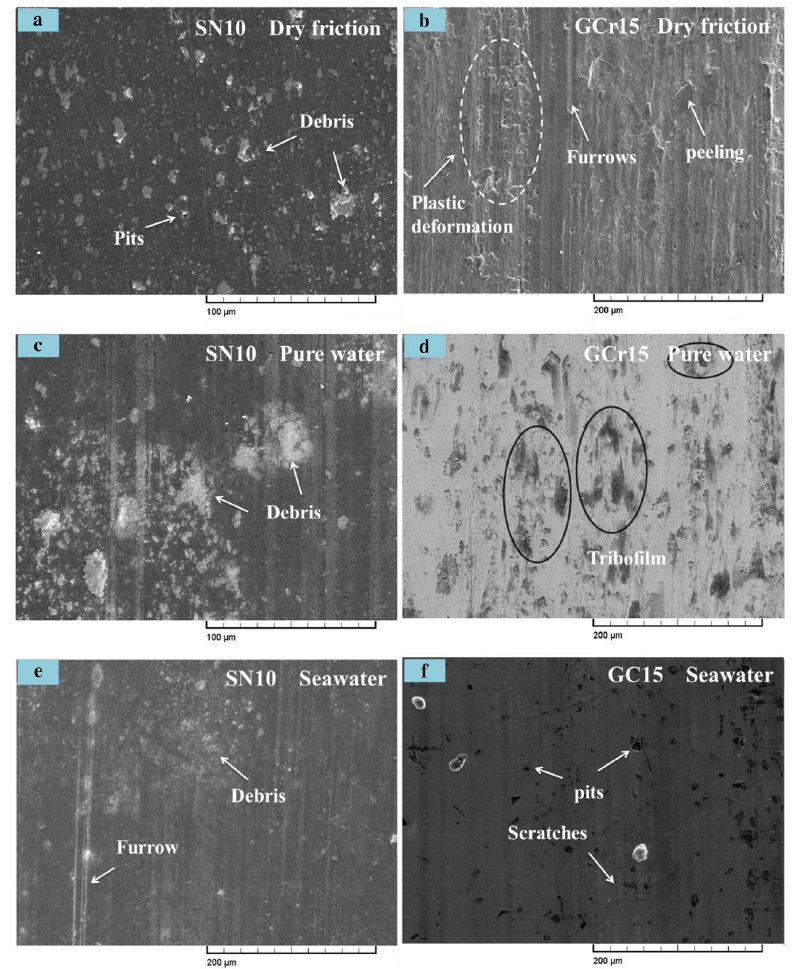
Figure 5. Scanning Electron Microscopy (SEM) images of the worn surfaces of SN10 ( a , c , e ) and GCr15 ( b , d , f ) under dry friction ( a , b ), pure-water lubrication ( c , d ), and seawater lubrication ( e , f ).